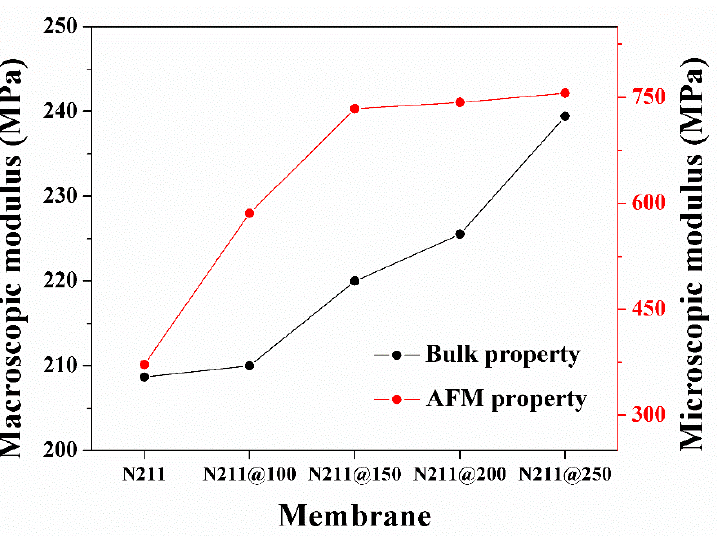
Figure 6. Microscopic and macroscopic Young’s moduli for pristine and thermally annealed mem- branes.